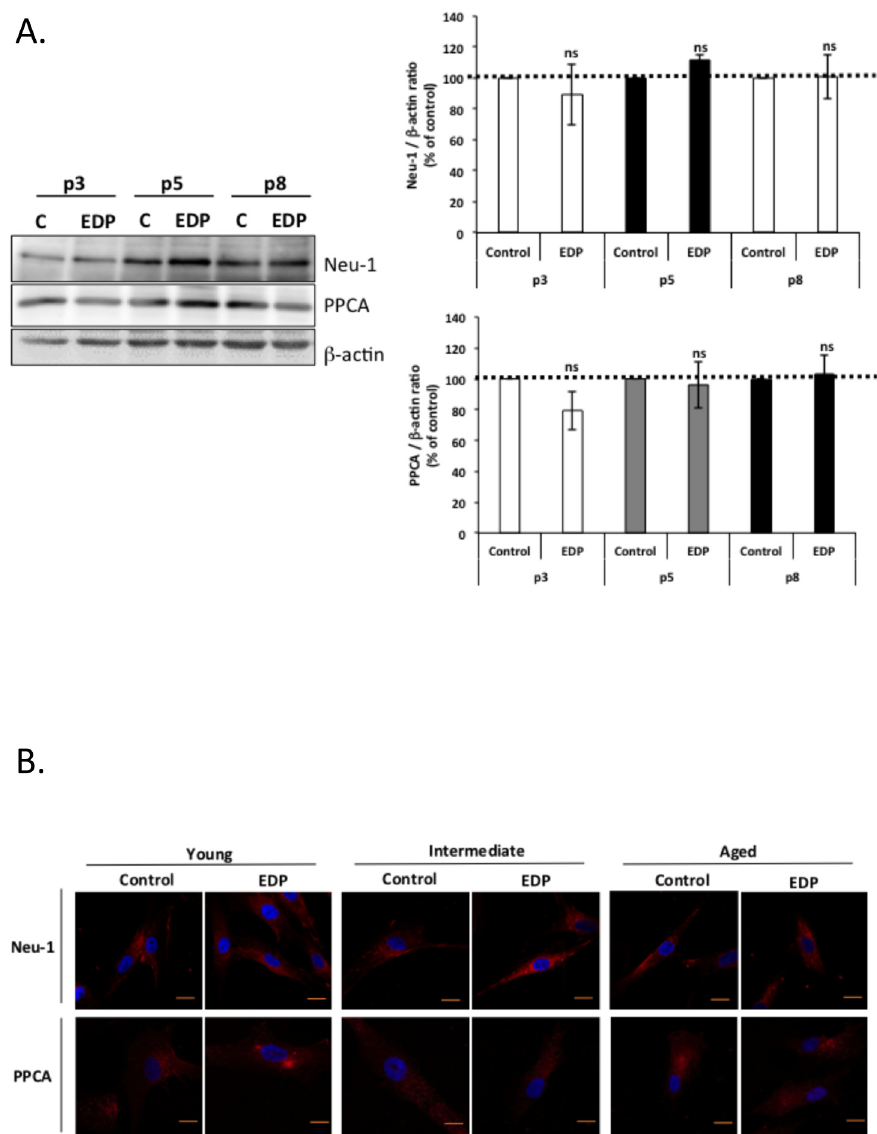
Fig 4. Analysis of protein expression and plasma membrane localization of Neu-1 and PPCA. Young, intermediate and aged fibroblasts were represented by passage 3 (white), 5 (grey) and 8 (black bars). (A) Analysis of Neu-1 and PPCA protein levels during aging. Cells were stimulated or not for 24 hours with 50 μ g/ mL of EDP before protein extraction. Neu-1 and PPCA were then analyzed by Western blotting using anti- Neu-1 and anti-PPCA antibodies. Densitometric analysis was performed using the Quantity One software. The results were expressed as the ratio Neu-1/ β -actin and PPCA/ β -actin and normalized to the control expressed in percent. Dotted lines (100%) represent the values of the unstimulated controls. (B) Analysis of Neu-1 and PPCA localization during aging. Neu-1 and PPCA cell localizations were analyzed by confocal microscopy. Bar, 10 μ